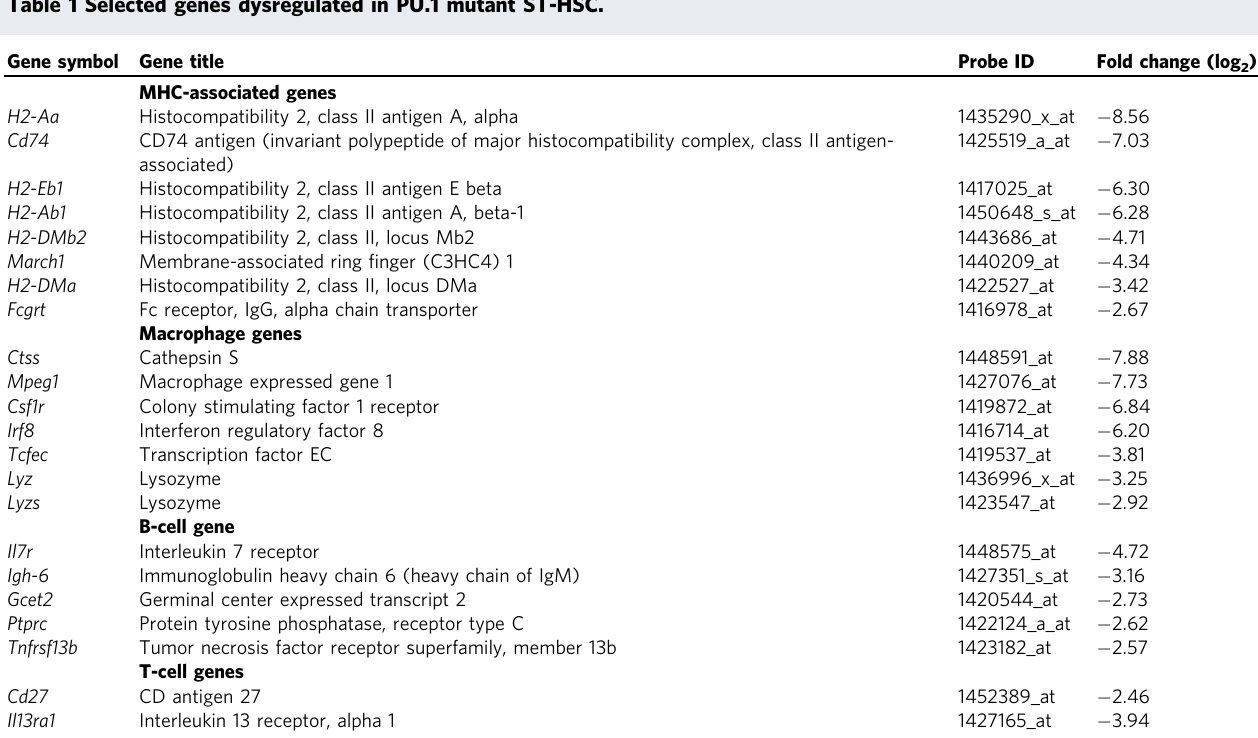
Table 1 Selected genes dysregulated in PU.1 mutant